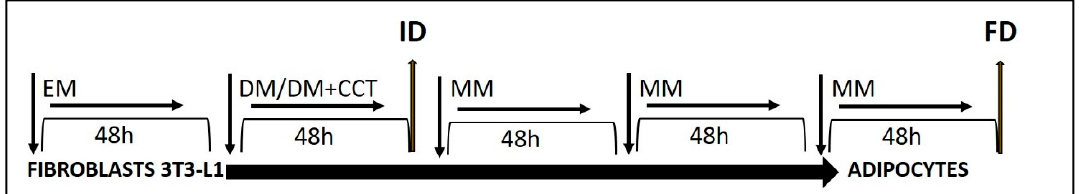
Figure 1. Schematic representation of the differentiation procedure to analyze the effects of crocetin (CCT). Fibroblasts achieved confluence after 48 h of treatment with expansion medium (EM). Then, the differentiation of confluent fibroblasts was induced with differentiation medium (DM; with or without CCT (1 or 5 µ M)) for 48 h. Subsequently, preadipocytes were maintained with maintenance medium (MM) for 6 days. ID, initial differentiation; FD, final differentiation.